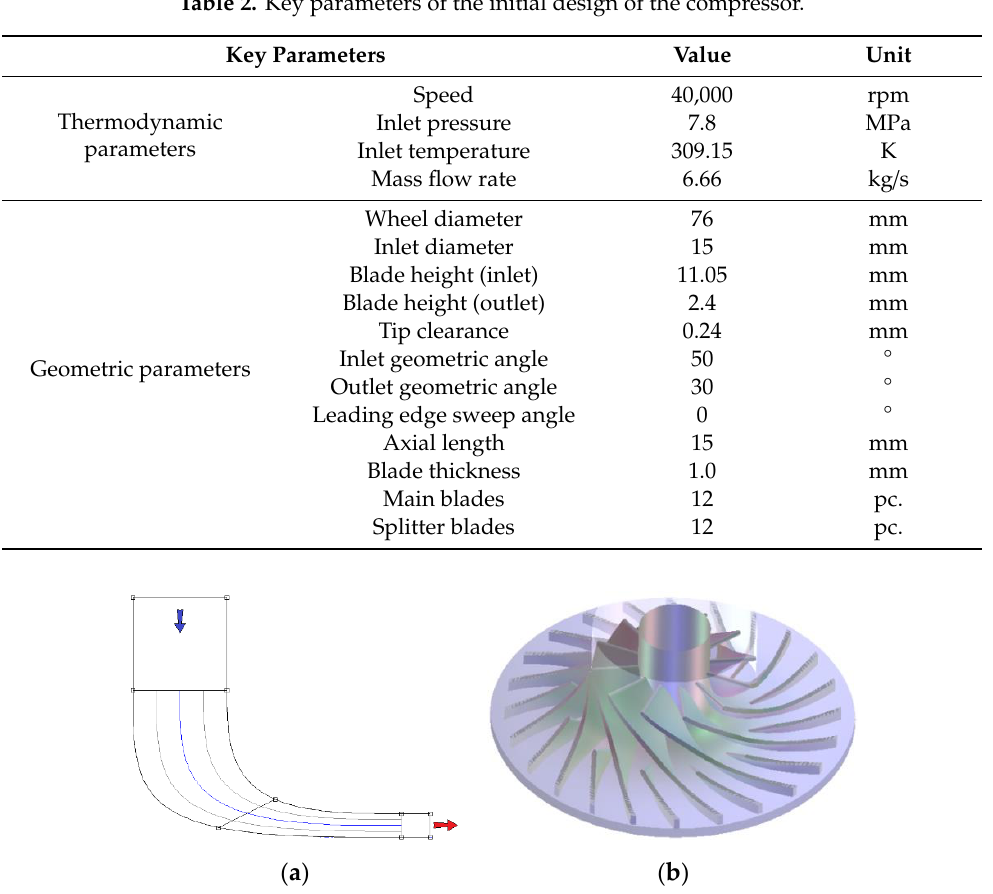
Figure 2. The initial design of the S-CO 2 centrifugal compressor: ( a ) rotor’s meridian face profile and ( b ) 3-D model.